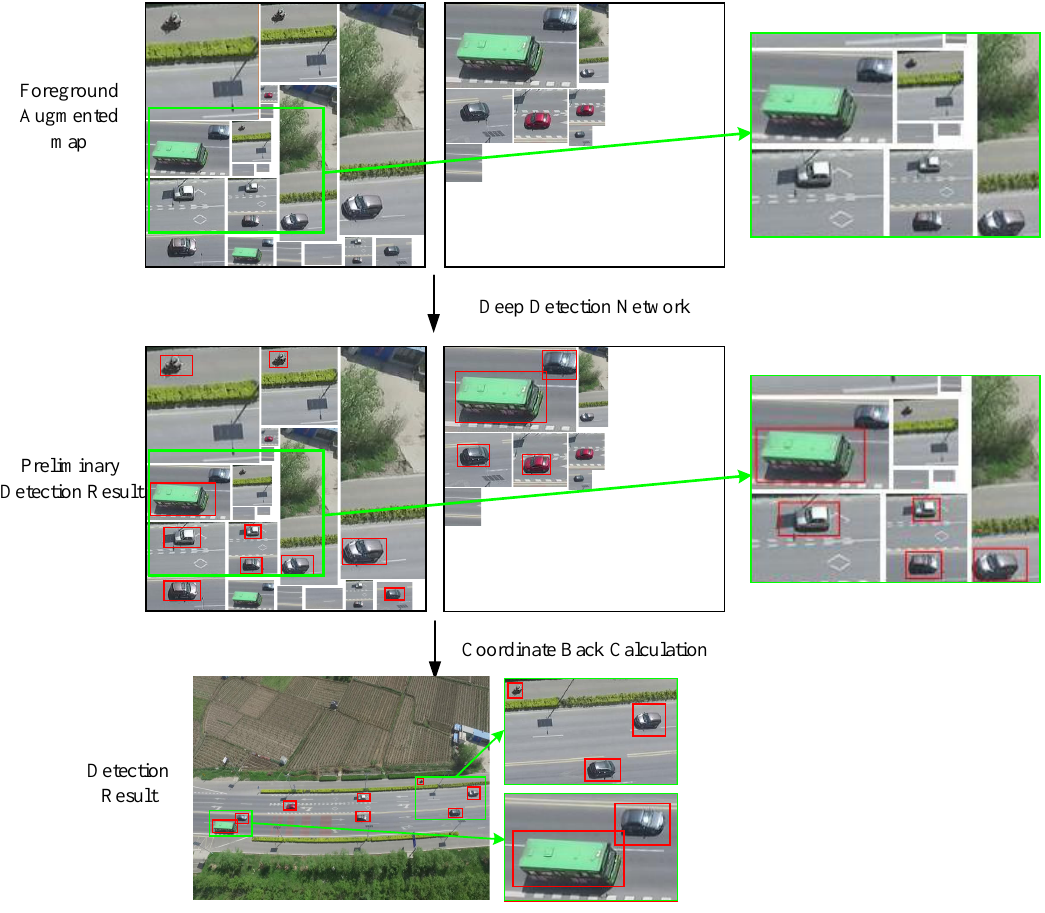
Figure 6. Small object detection with the deep network. First, on the basis of the YOLO v2 deep detector, targets are preliminarily detected. Second, we inversely calculate the coordinates in the foreground space into an input aerial image and get the final small object detection